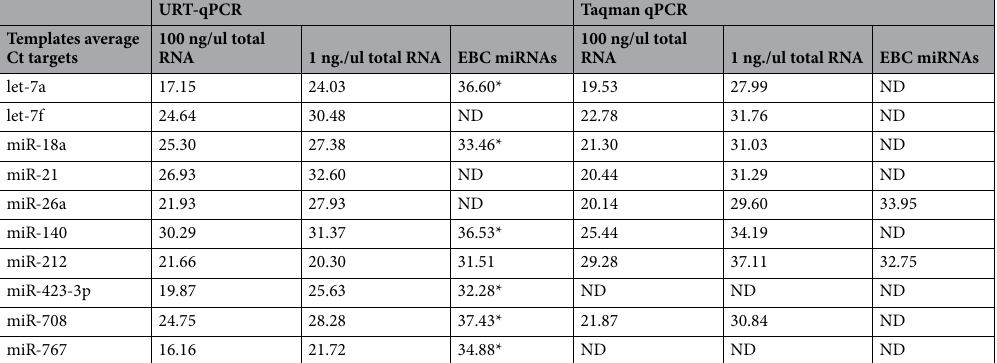
Table 1. URT-qPCR versus Taqman qPCR. Numbers represent Ct values. ND = not detected , * Detected in URT, but not detected in the TaqMan platform.